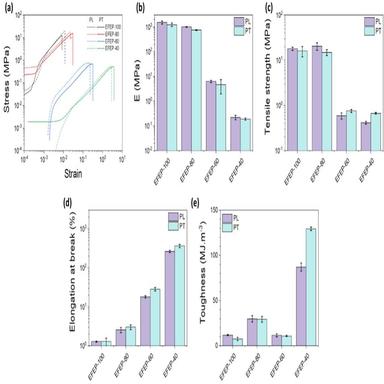
(a) Stress vs strain curves of specimens printed longitudinally PL and transversally PT; (b) Comparison of the elastic modulus E for specimens printed longitudinally PL and transversally PT; (c) Comparison of the ultimate tensile strength for specimens printed longitudinally PL and transversally PT; (d) Comparison of the elongation at break for specimens printed longitudinally PL and transversally (PT); (e) Comparison of toughness for specimens printed longitudinally PL and transversally (PT).